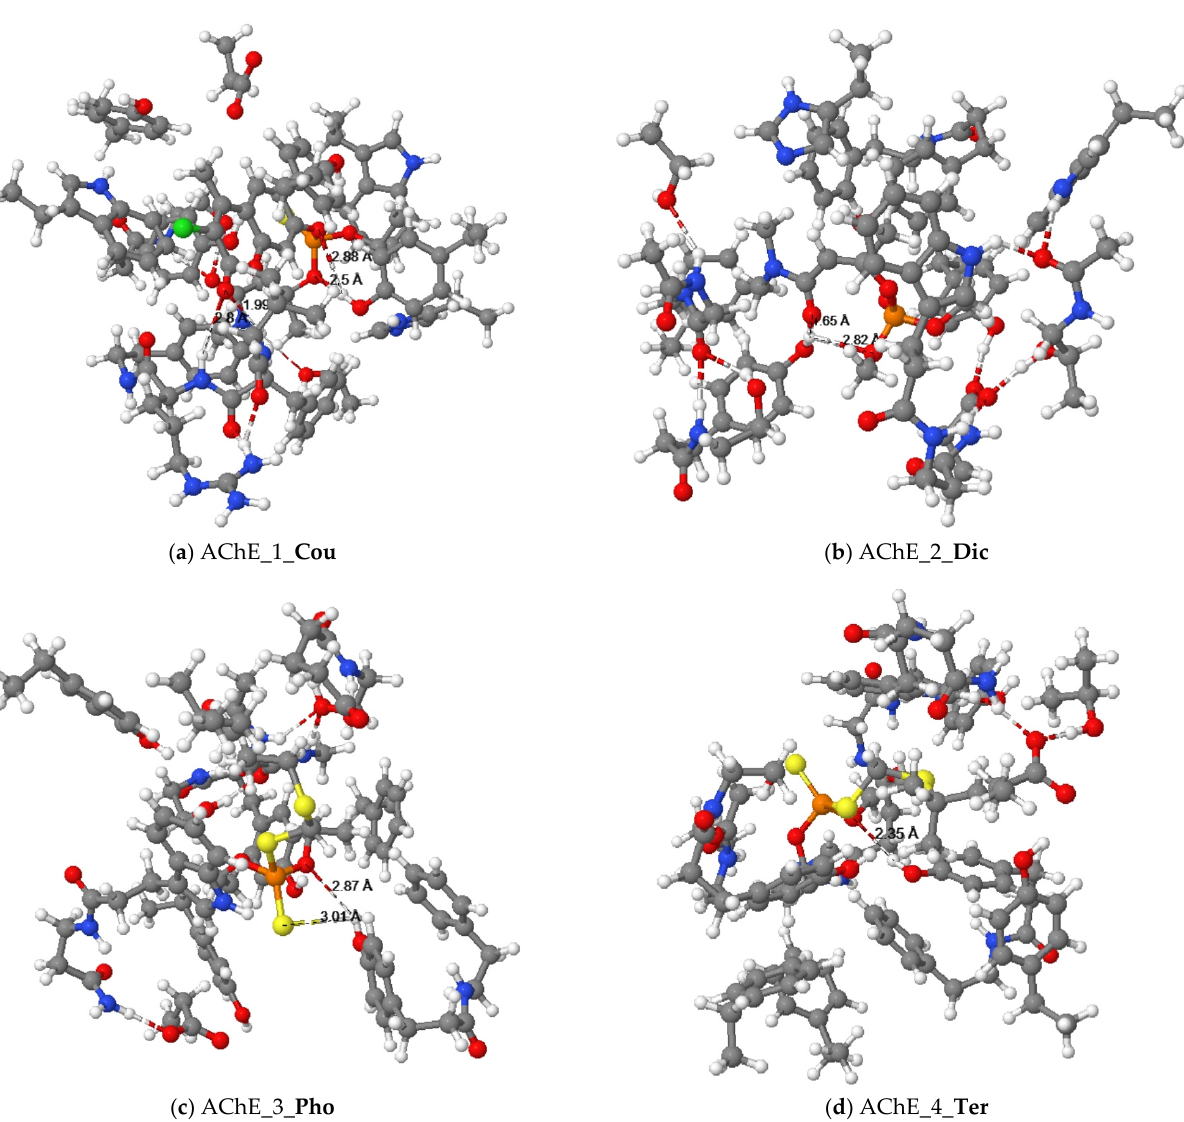
Figure 3. Equilibrium structures of organophosphorus pesticides (( a ) Cou , ( b ) Dic , ( c ) Pho and ( d ) Ter ) binded with cluster models of the human AChE enzyme.